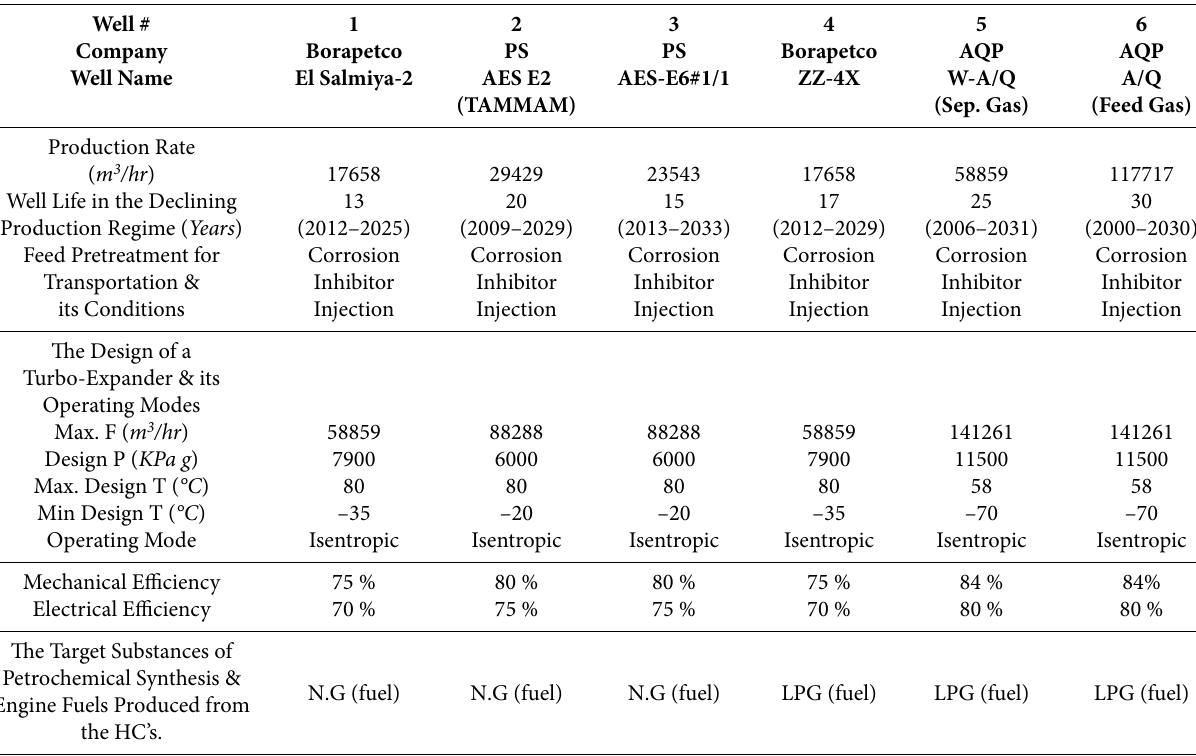
Table 2. Feed operating